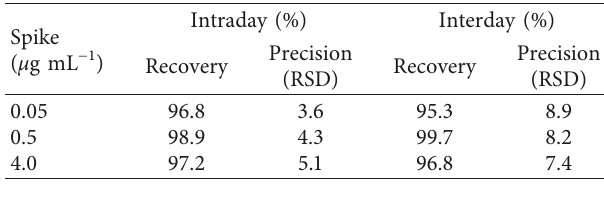
Figure 7: Representative chromatograms of patient plasma sample (a) and blank plasma (b). Table 4: Recoveries and precision ( n � 5).